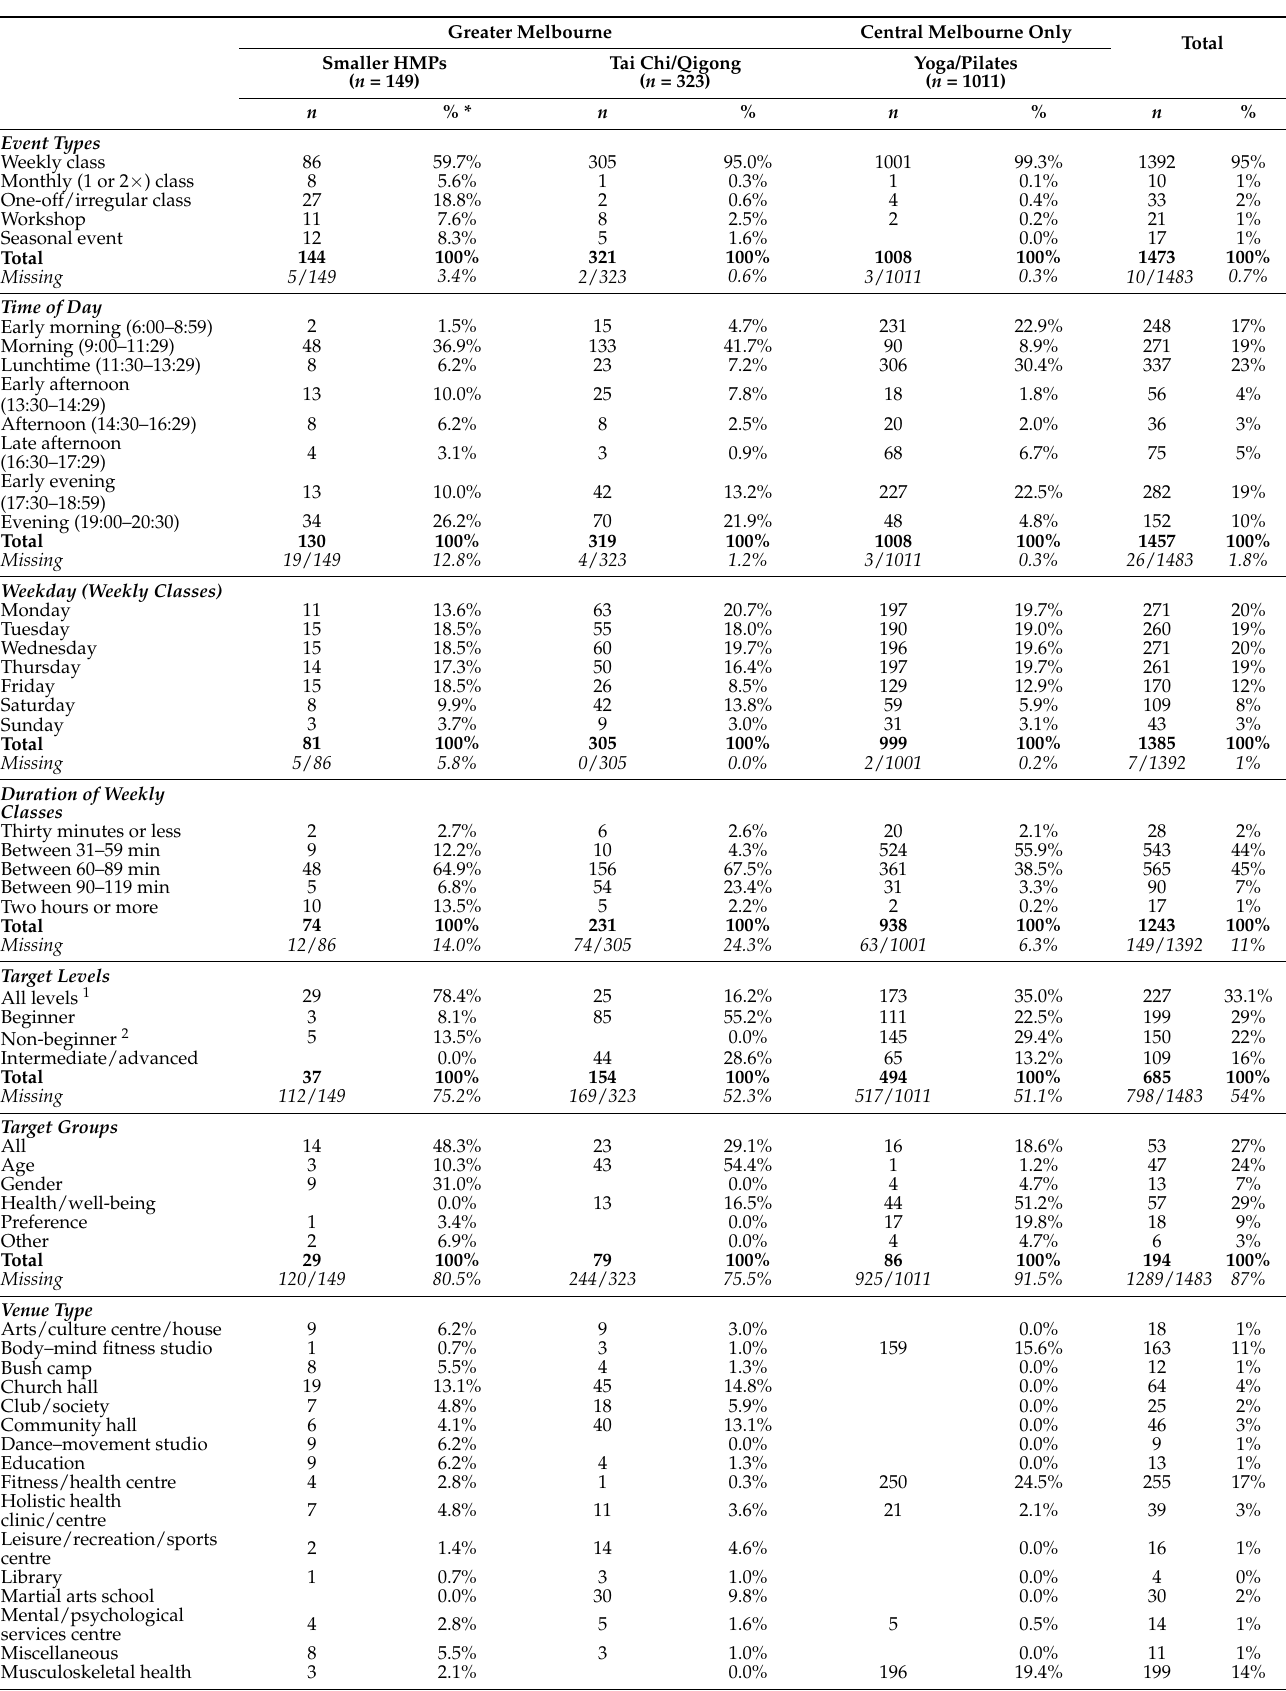
Table 2. Event characteristics for the smaller HMPs, Tai Chi/Qigong, and